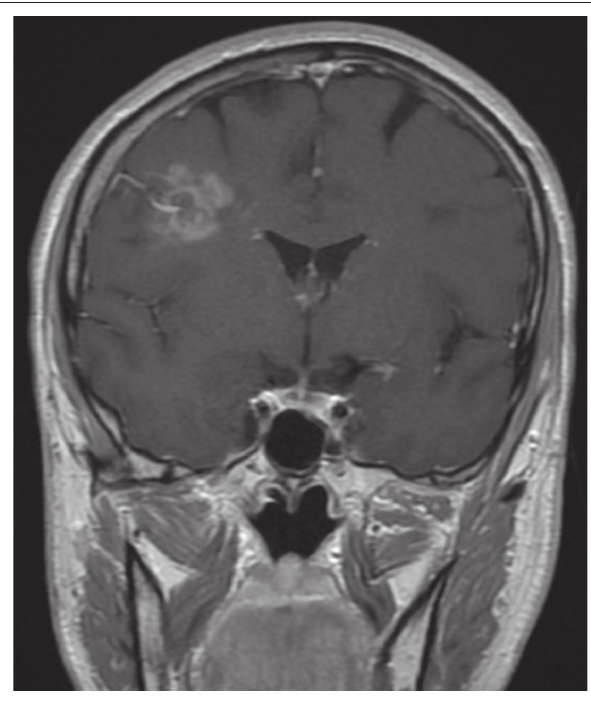
FIGURE 4: Coronal post contrast T1-weighted MR image.